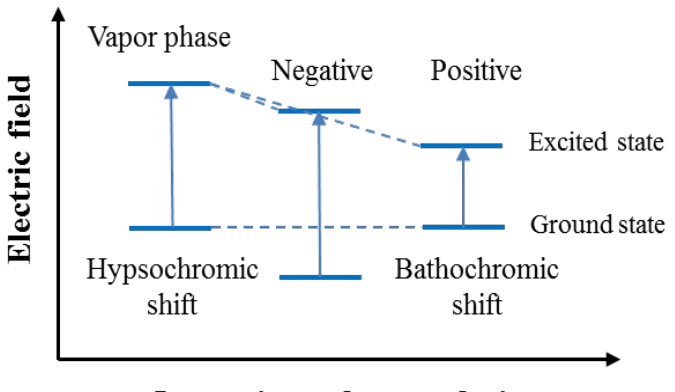
Figure 2. Schematic diagram of